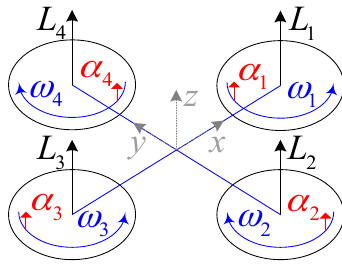
Figure 2. The control inputs and the frames of reference for the variable-pitch quadrotor.